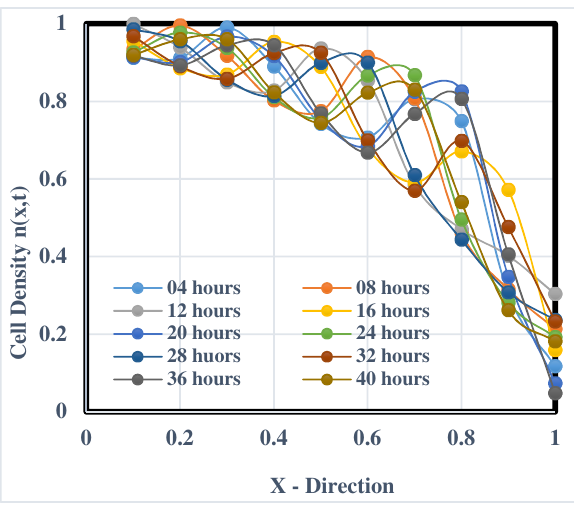
Fig. 6. Cell density for 10 steps of time with 4 hours per each, and through the length from the limbus to the center of healing (center of the eye).